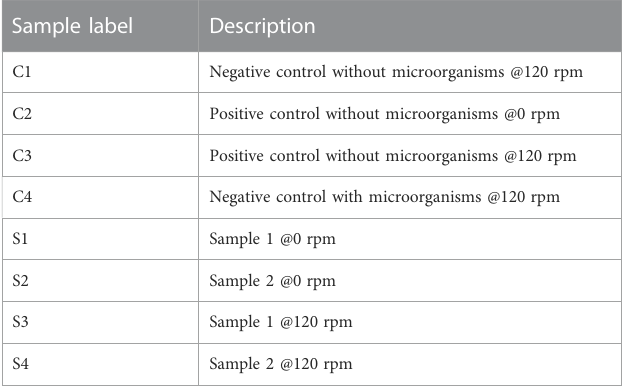
TABLE 1 Sample labels with corresponding descriptions (if not stated differently in the graphs and fi gures). Sample label